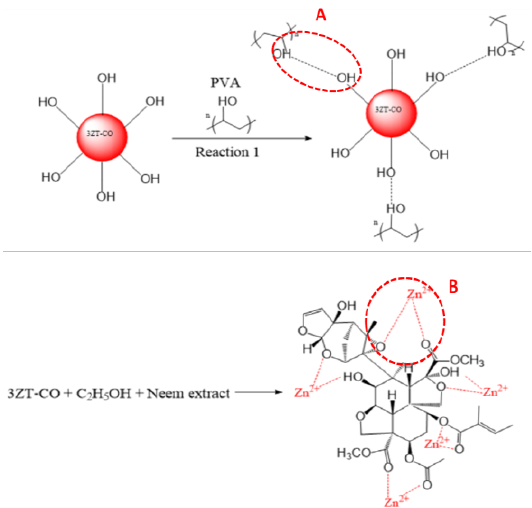
Figure 5. ( A ) PVA grafting on 3ZT-CO particle. ( B ) Stearic stabilization by neem in